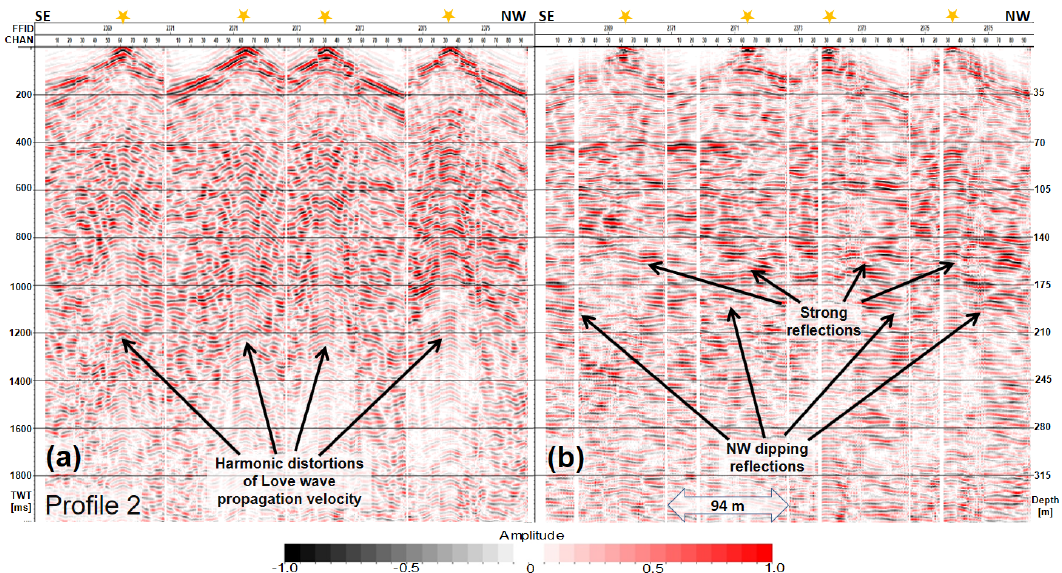
Figure 7. (a) A consecutive set of recorded shot gathers (AGC of 220ms window; amplitude scaling and bandpass filter (18-20-76-82Hz) applied) in the time domain in an area of good reflectivity along profile 2 (labelling as in Fig. 5). Parts of the records are disturbed by harmonic distortions centred on the source position and propagating with Love wave velocity ( ∼ 200ms − 1 ). In (b) the disturbing pattern is removed, uncovering the reflection events below. For a raw time-to-depth estimation, a depth scale is added on the right based on a mean velocity of 350ms − 1 for body shear waves. In (b) Topmute (step 8 in Table 1) is also